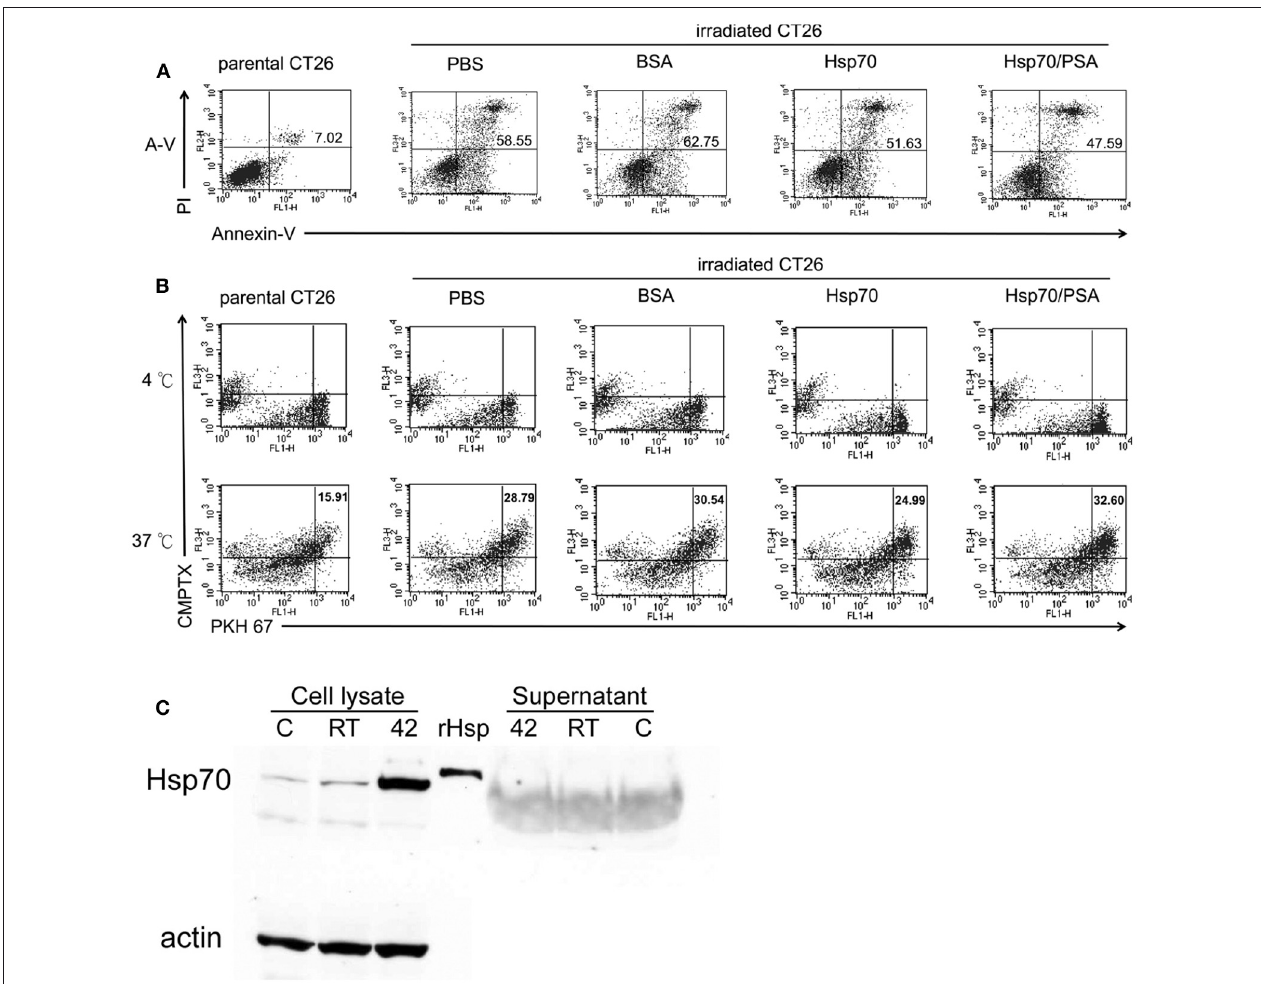
FIGURE A1 | Exogenous rHsp70 did not increase radiation–induced CT26/PSA apoptosis nor increase BM-DC phagocytosis. (A) The percentage of apoptotic CT26/PSA cells was analyzed by annexin-V and PI (propidium iodide) staining (shown in the upper right corner) in, left